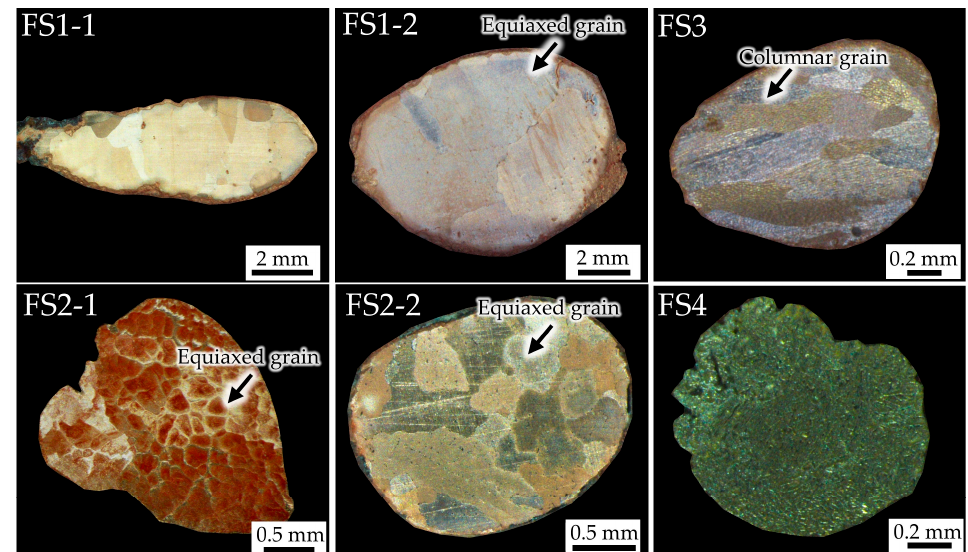
Figure 6. Etched microstructure of the molten marks (overview).